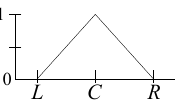
Figure 2. Triangular